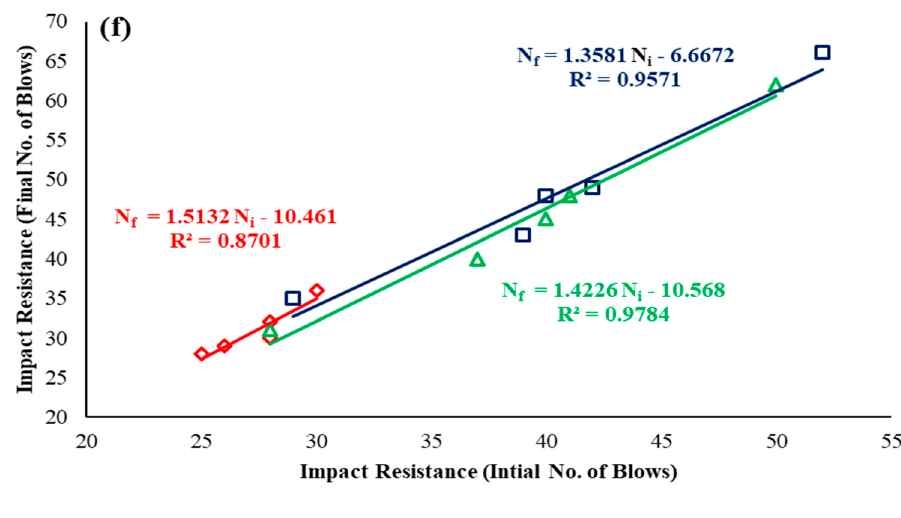
Figure 15. Relationship between ( a ) steel slag (%) and compressive strength; ( b ) compressive strength and splitting tensile strength; ( c ) compressive strength and flexural strength; ( d ) compressive strength and modulus of elasticity; ( e ) compressive strength and impact resistance (final No. of blows); ( f ) impact resistance (initial No. of blows vs. final No. of blows). The experimental data have also been compared with ACI-318M-14 [60] strength- predicting models for the relationships between compressive strength and other mechanical parameters, and the results are shown in Figure 16a–c. It is evident from the obtained results that the experimental data are better compared with the ACI-expected data.